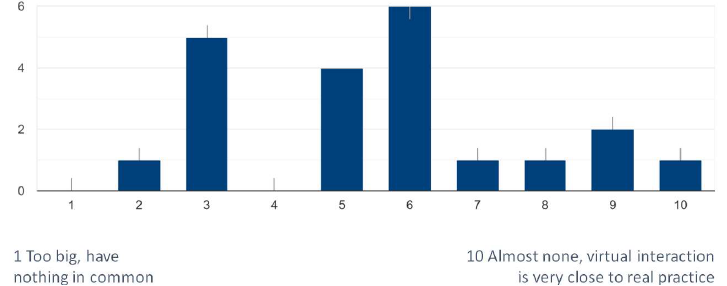
Figure 12: Comparison of real and virtual devices